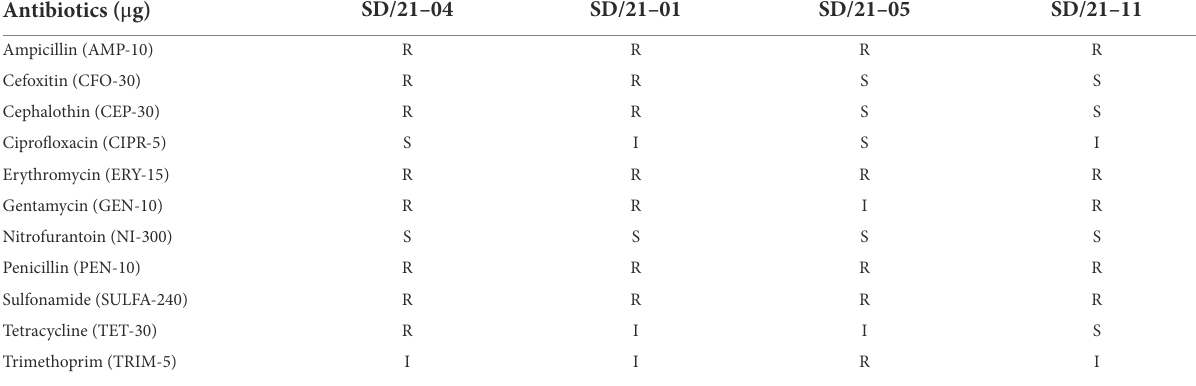
TABLE 2 Antibiotic susceptibility of Aeromonas spp. based on disk diffusion